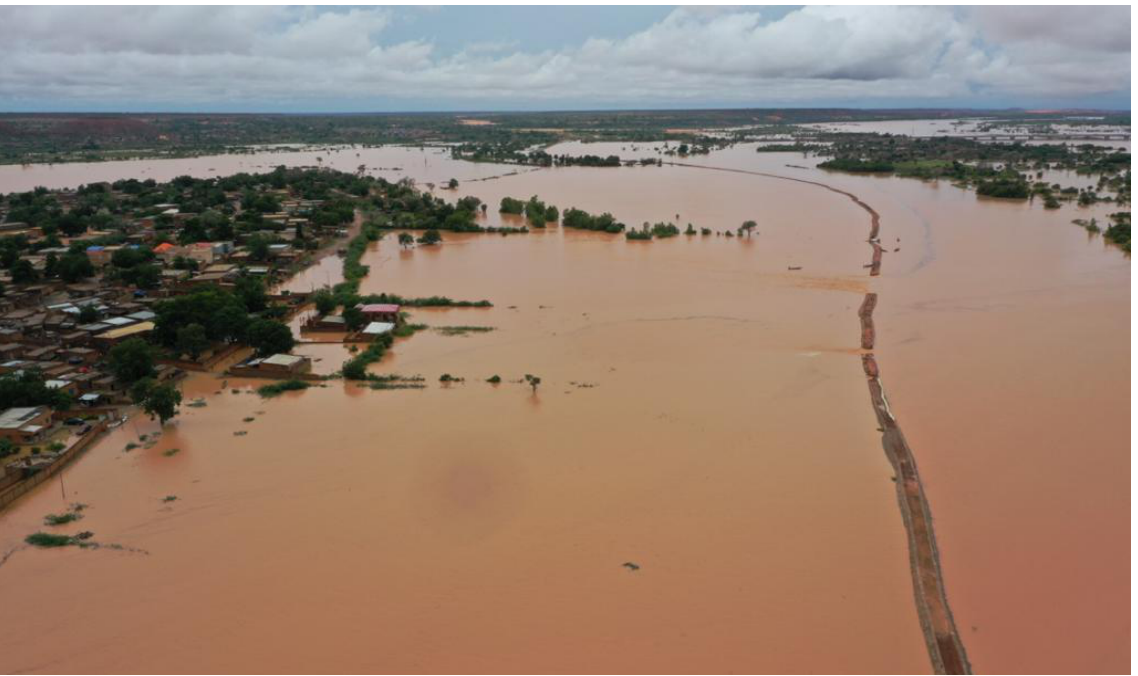
Figure 4. The Niger River in Niamey on 7 September 2020: The Lamordé levee and district on the right bank from the downstream aerial point of view (Author: Direction Générale de la Protection Civile du Niger).